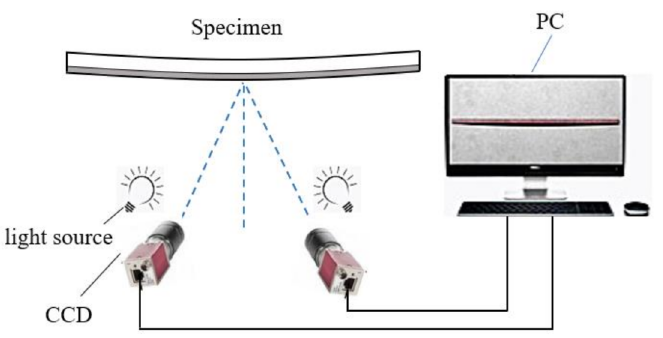
Figure 5. Schematic diagram of a 3D DIC system for morphology measurement of TBC